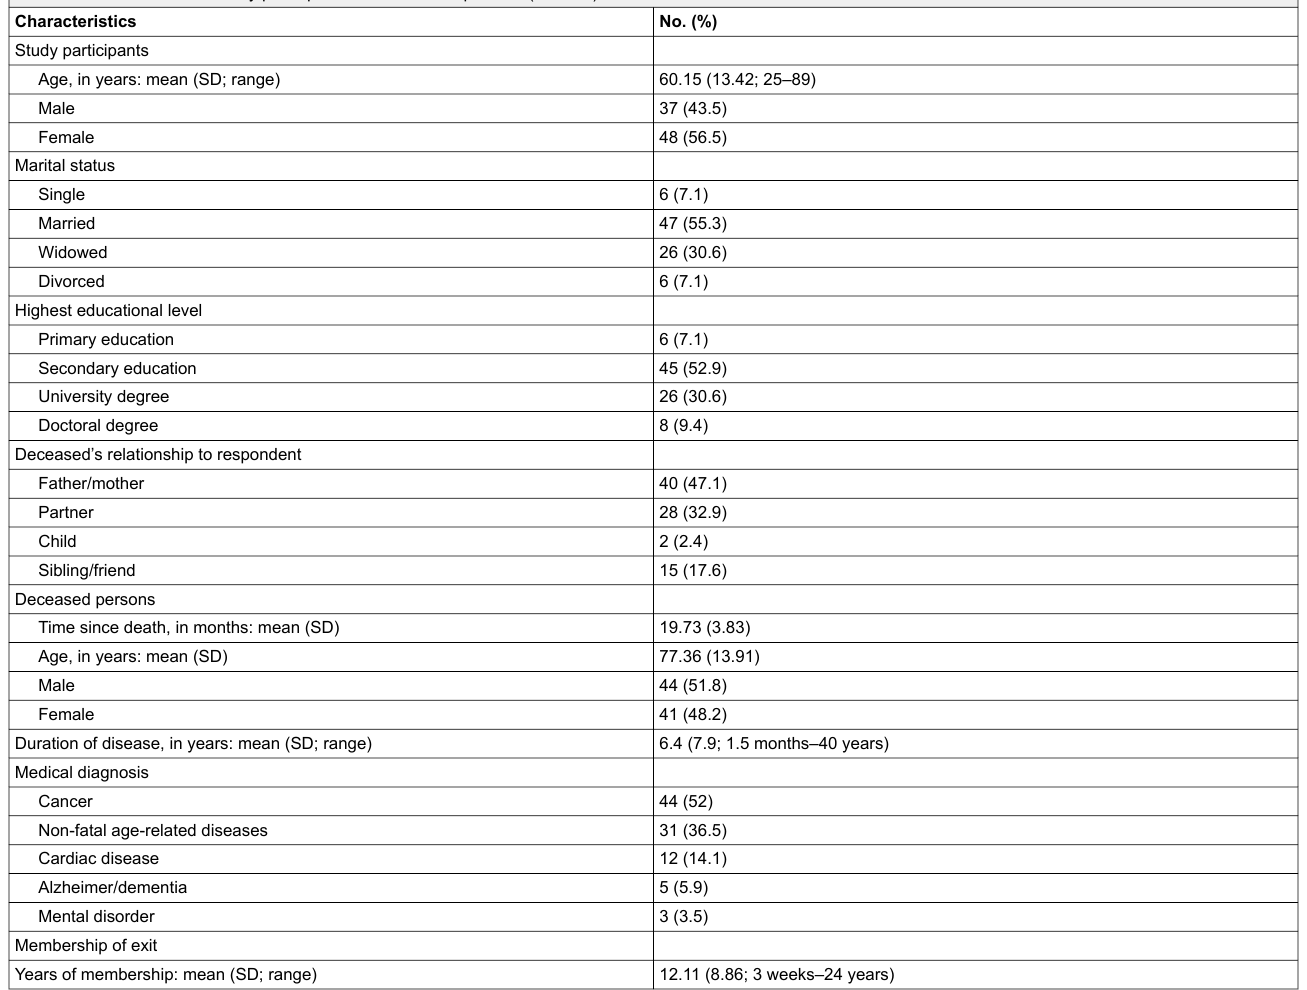
Table 1: Characteristics of study participants and deceased persons (Ns = 85).